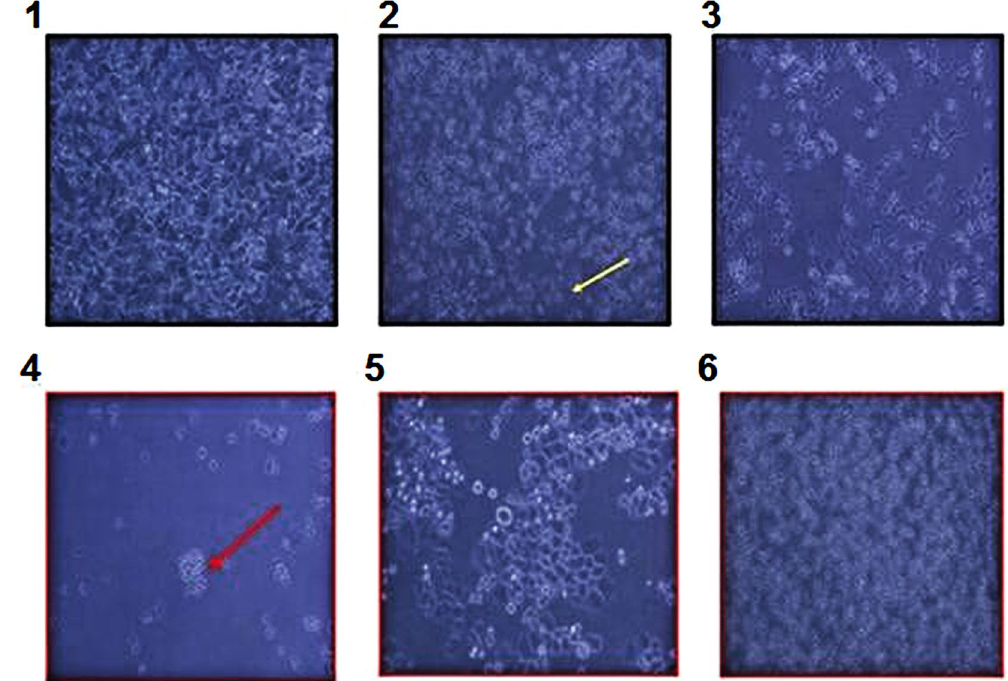
Figure 1. Induction, screening and selection of trastuzumab-resistant cells. 1. cells before exposed to trastuzumab, 2 and 3, cells exposed to trastuzumab, showing apoptosis, 4 and 5, resistant colony and proliferation of resistant cells, and 6, stable resistant cells growing in medium containing 8 μ g/ml trastuzumab. Red arrow indicates resistant cell and colony and yellow arrows indicates apoptotic cell and